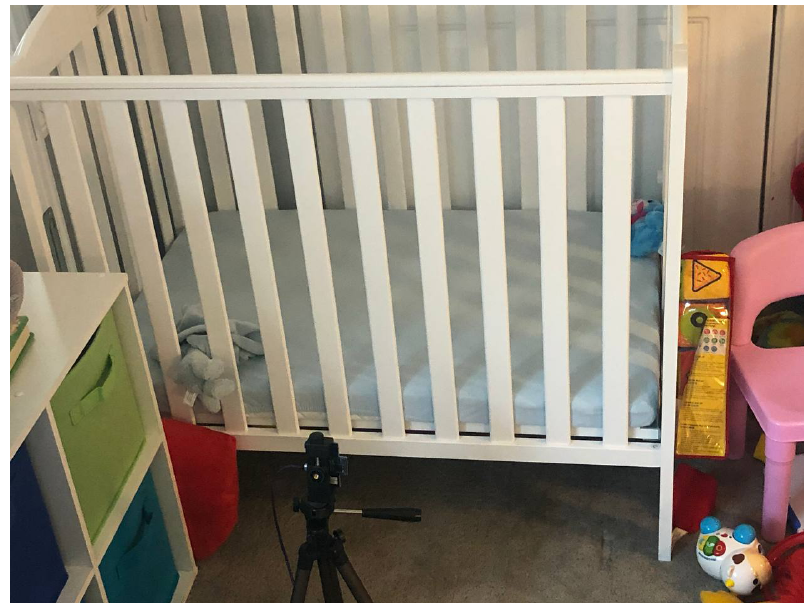
Figure 5. Baby crib—radar setup.